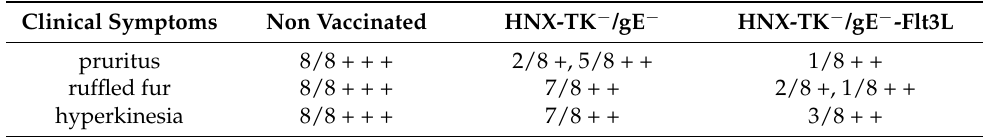
Figure 7. Protective effect of HNX-TK − /gE − -Flt3L in mice. Three groups of mice were intramuscularly immunised twice with HNX-TK − /gE − , HNX-TK − /gE − -Flt3L or DMEM, and then challenged with HNX strain. ( A ) Survival rate. ( B ) Cytokine MCP-1, ( C ) IL-6, and ( D ) CXCL10 levels in the plasma samples through cytokine ELISA at 72-h post challenge. *, p < 0.05. Table 1. The severity of clinical symptoms in mice of PRV challenge for 2